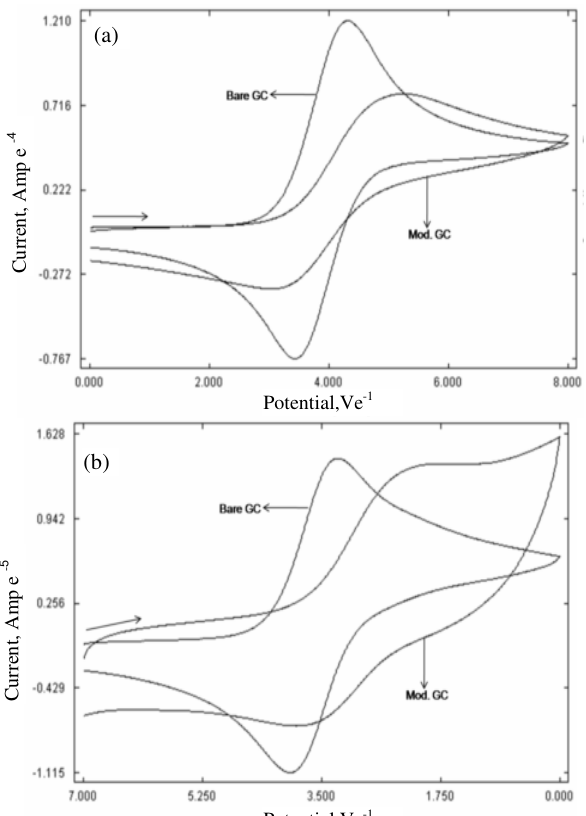
Figure 5 . Overlaying surface voltammograms for first peak (a) the bare GC and HIBD modified GC with ferrocene and than (b) the bare GC and HIBD modified GC with ferricyanide